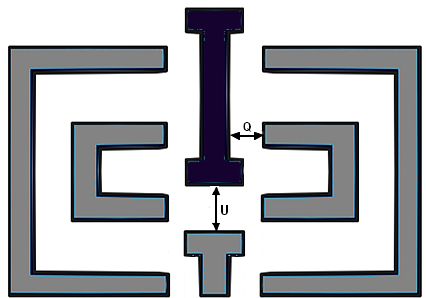
Figure 6. Position of the central column at maximum tilt U = 8 µ m and position of Q at zero tilt.